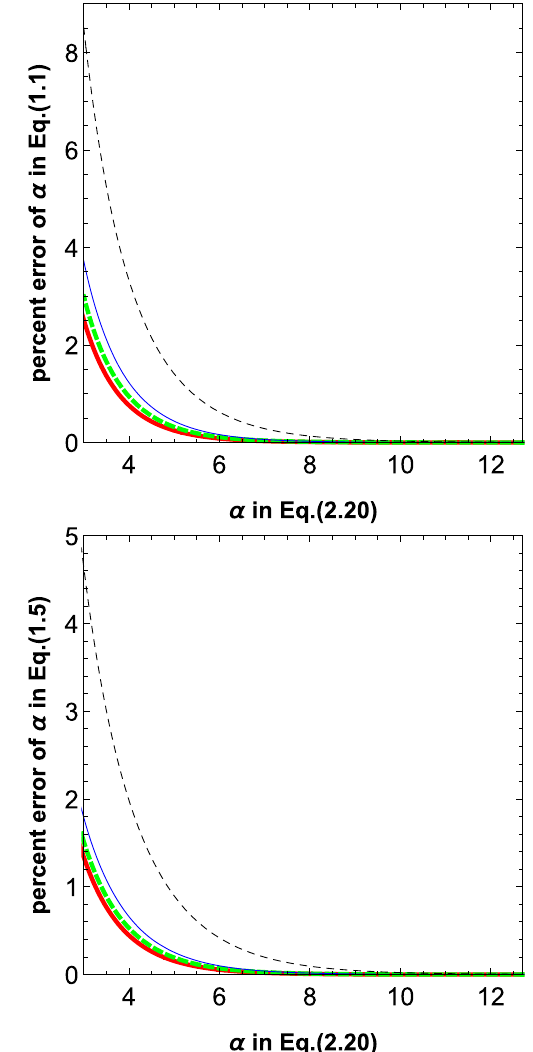
Fig. 1 ThepercenterrorsofdeflectionanglesintheSchwarzschildand Reissner–Nordström black hole spacetimes. The percent errors of the deflection angles in Eqs. (1.1) and (1.5) against the deflection angle in Eq. (2.20) are shown in the upper and lower panels, respectively. Wide solid(red),widedashed(green),narrowsolid(blue),andnarrowdashed (black) curves show the percent errors in the cases of Q / M = 0, 0 . 6, 0 . 8, and 1,